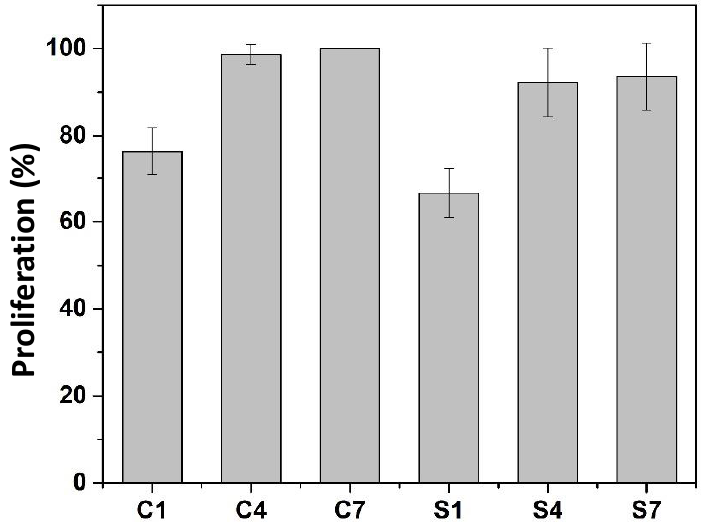
Figure 12. The positive cell growth curves at incubation periods of 1, 4, and 7 days, respectively, control 1 day (C1), control 4 days (C4), control 7 days (C7), sample SiO 2 /ZrO 2 /TMSPMA 1 day (S1), SiO 2 /ZrO 2 /TMSPMA 4 days (S4), and SiO 2 /ZrO 2 /TMSPMA 7 days (S7).